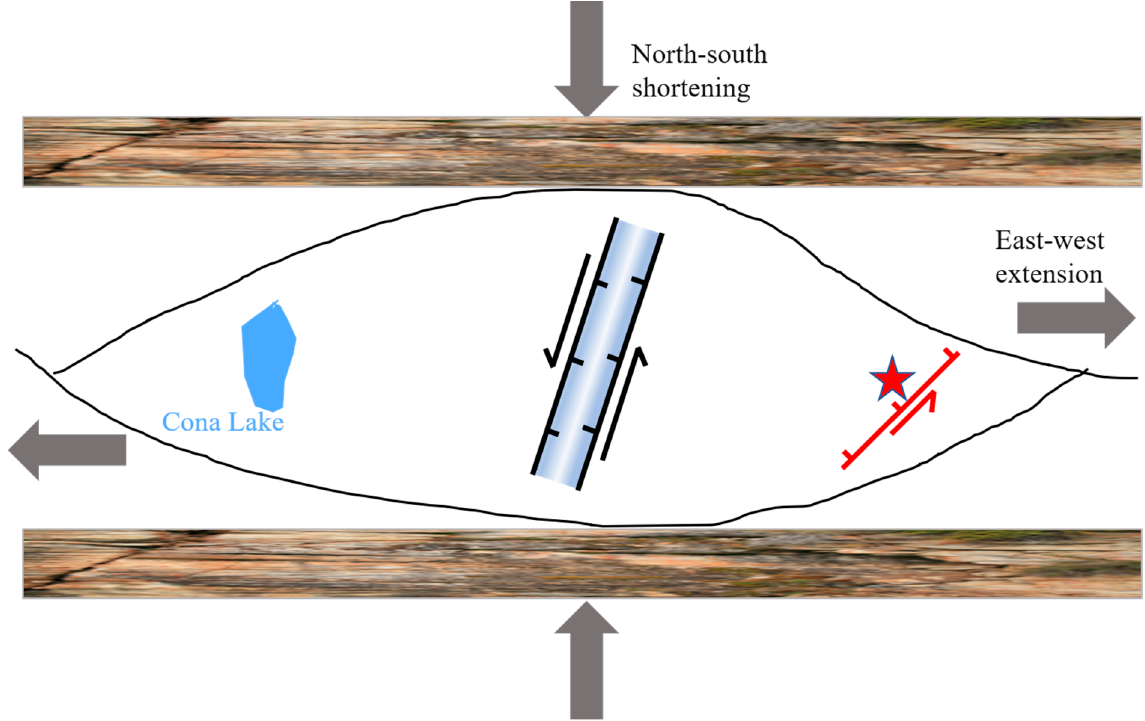
Figure 8. Schematic illustration of the seismogenic mechanisms of the 2021 Nagqu Mw 5.7 earth- quake.